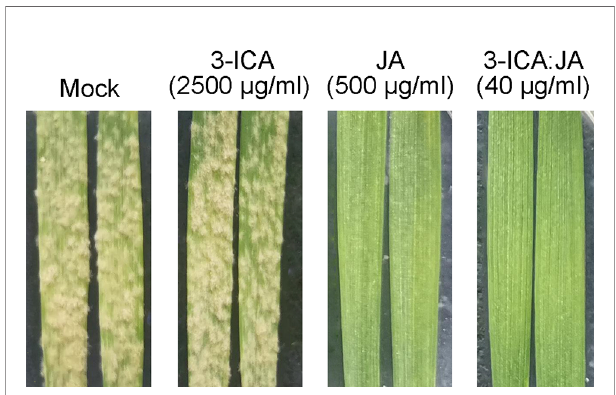
FIGURE 2 | The activity of 3-ICA, JA, and their combinations against wheat powdery mildew at 2,500, 500, and 40 m g/ml, respectively. Mock, untreated control; 3-ICA, indole-3-carboxylic acid; JA, jasmonic acid; 3-ICA:JA, the 2:8 combination of indole-3-carboxylic acid and